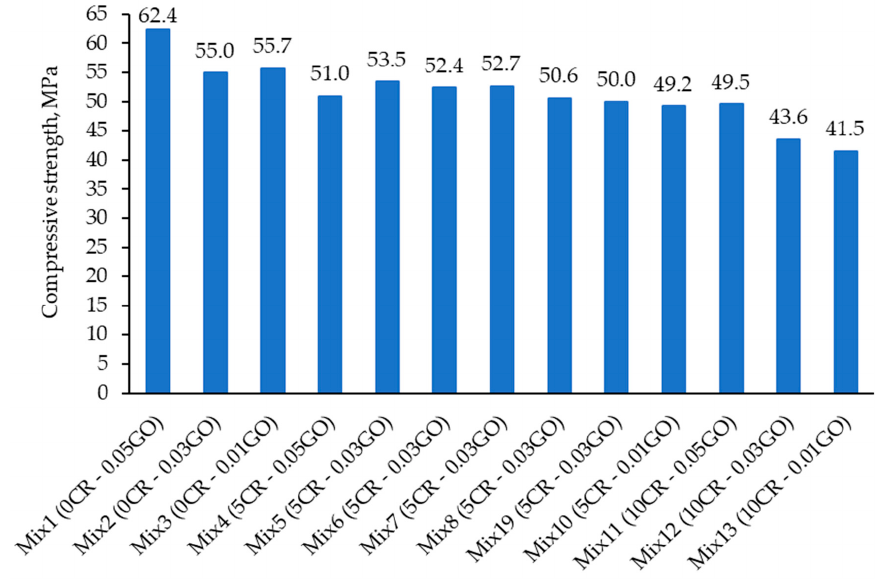
Figure 4. Compressive strength test results of the mixtures at 28 days.